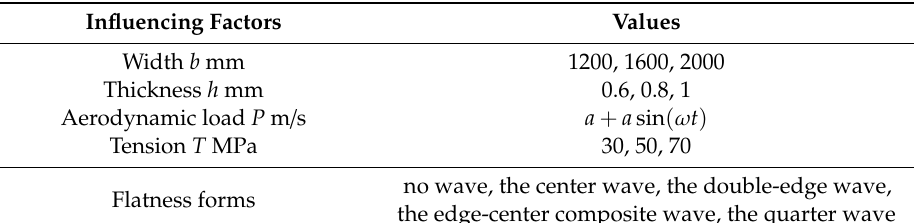
Table 1. Conditions under di ff erent combinations of factors.